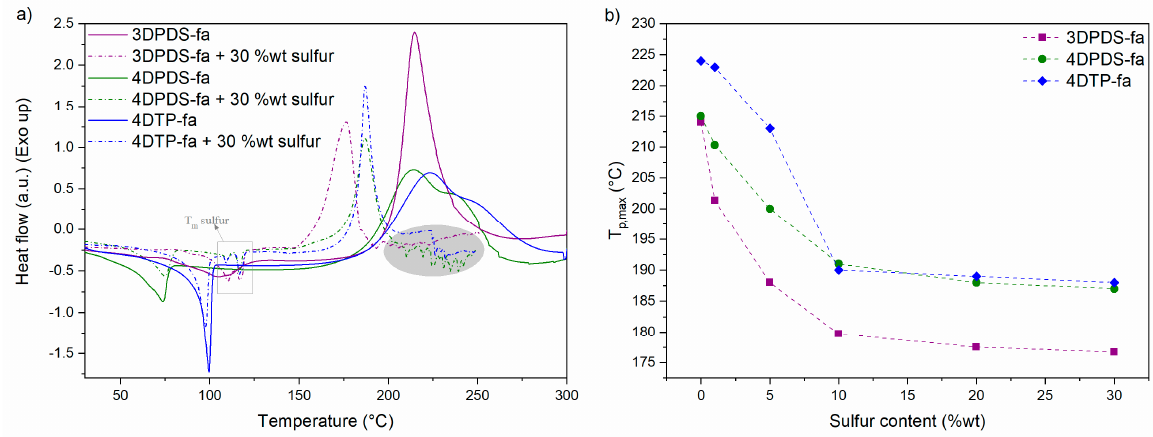
Figure 4. ( a ) DSC thermogram of 3DPDS-fa, 4DPDS-fa, and 4DTP-fa without and with 30 %wt of sulfur; ( b ) Maximum temperature of the exothermic peak of 3DPDS-fa, 4DPDS-fa, and 4DTP-fa as a function of sulfur content. Dash lines serve to guide the eye.